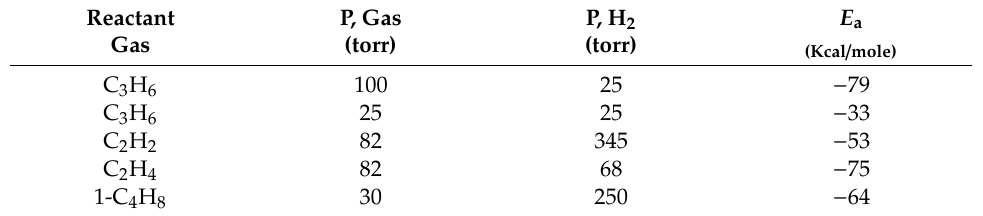
Table 2. Carbon formation on Ni foils. Negative activation energies observed in the surface reaction-step